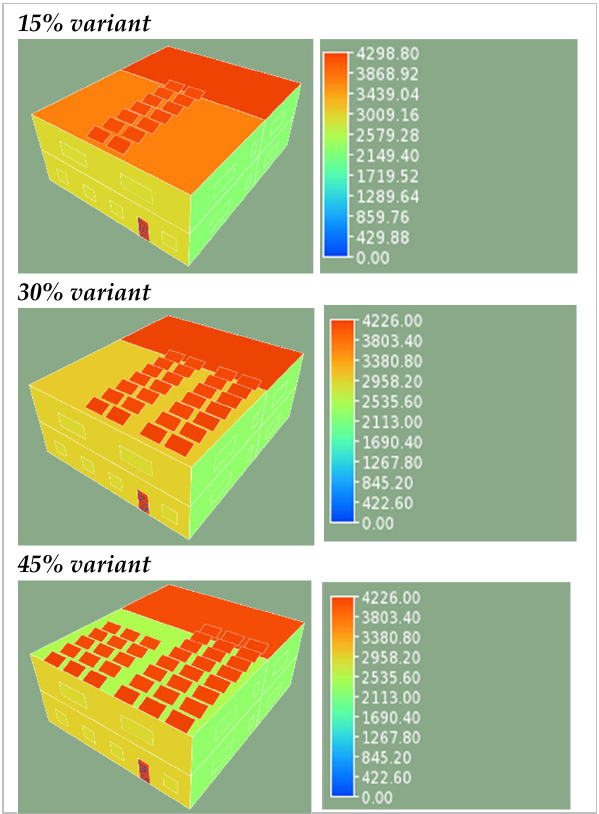
Figure A1. The thermal diagram of the rooftop PV variants .